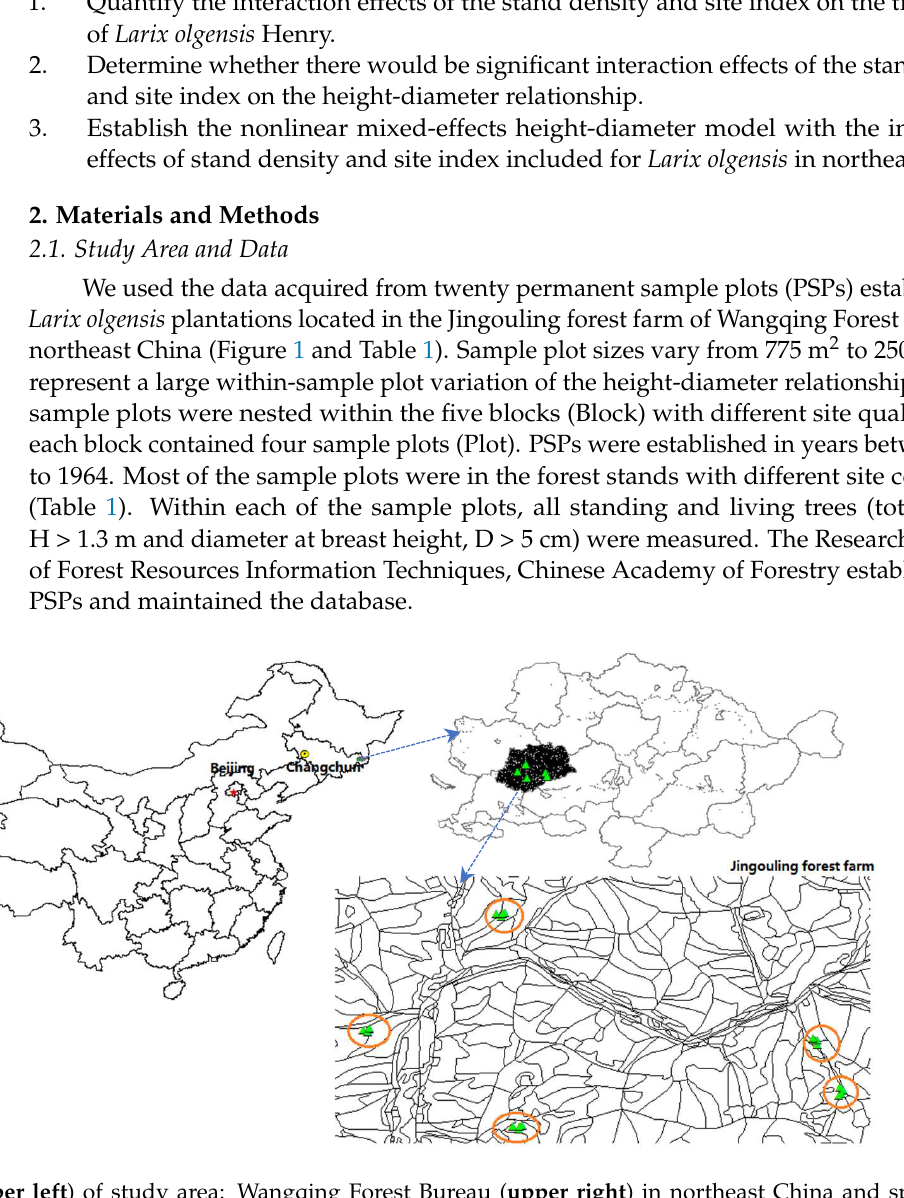
Figure 1. Location ( upper left ) of study area: Wangqing Forest Bureau ( upper right ) in northeast China and spatial distribution of 5 blocks and 20 sample plots ( bottom ). Table 1. A total of 765 Larix olgensis trees in 20 PSPs with 14 types of M ∗ S and 2 altitude levels. Number of Larix olgensis trees (Numbers), stand density class (M), and site index class (S) of each sample plot in model fitting data and model testing data can be seen in this table. (Note: A = altitude of the sample plot; A = 1 when the altitude of the sample plot is higher than 700 m; A = 2 when the altitude of the sample plot is less than 700 m. M= stand density class of the sample plot; S= stand index class of the sample plot. The ranges of M and S are shown in Table 2).